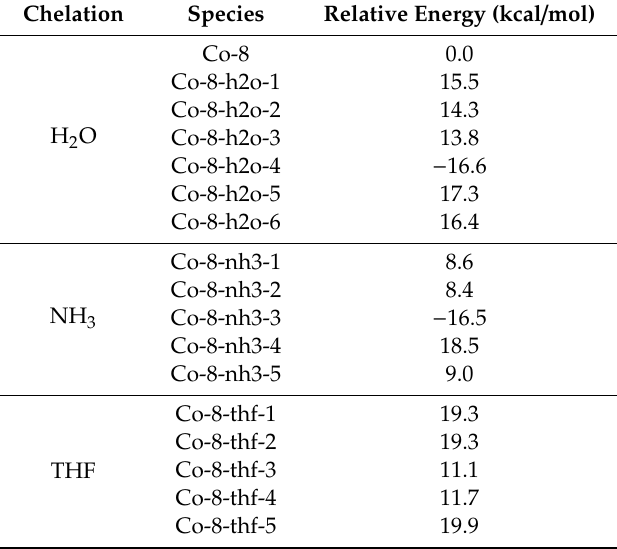
Table 4. The effect of H 2 O, NH 3 and THF on the stabilization of complex I-8 (Ada-PNP-Co).